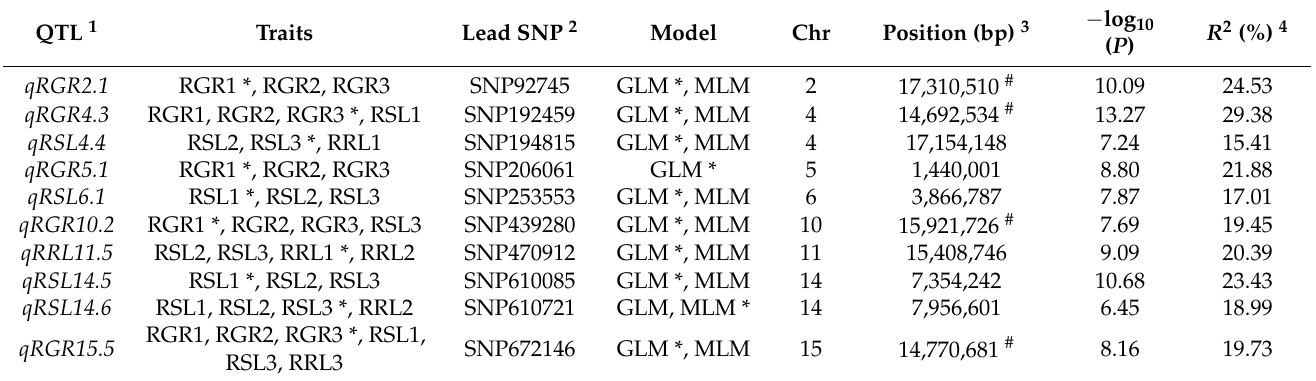
Figure 3. Physical map of 64 QTLs. QTLs repeatedly detected at the same SNP locus in three environments are marked in red. QTLs overlapping with those of Soto-Cerda et al. 2019 were marked in orange boxes. QTLs overlapping with those of Sertse et al. 2021 were marked in green boxes. QTLs overlapping with those of Soto-Cerda et al. 2020 and Sertse et al. 2021 were marked in blue boxes. Table 1. Ten QTLs were detected in all three